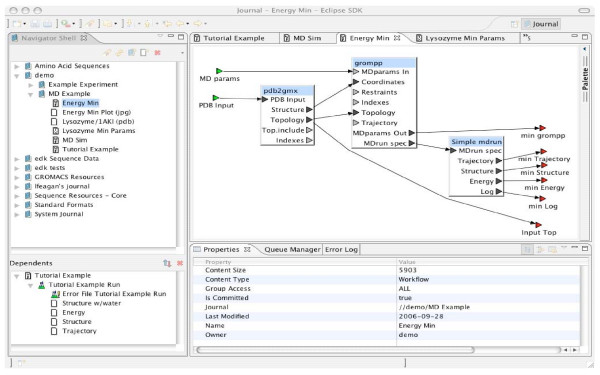
Sample BCJ Session.